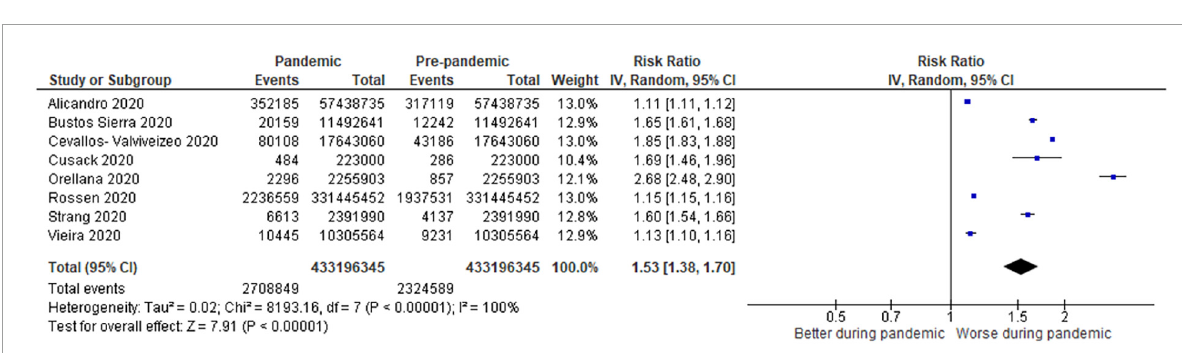
FIGURE3 Forest plot for all–cause excess mortality. CI, confidence intervals; COVID-19, coronavirus disease 2019; IV, inverse variance.